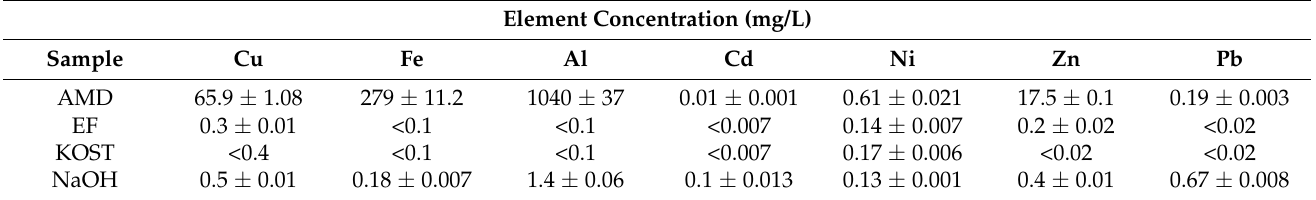
Table 8. Comparison of the metal concentration after neutralization treatment with fly ashes EF, KOST, and commercial